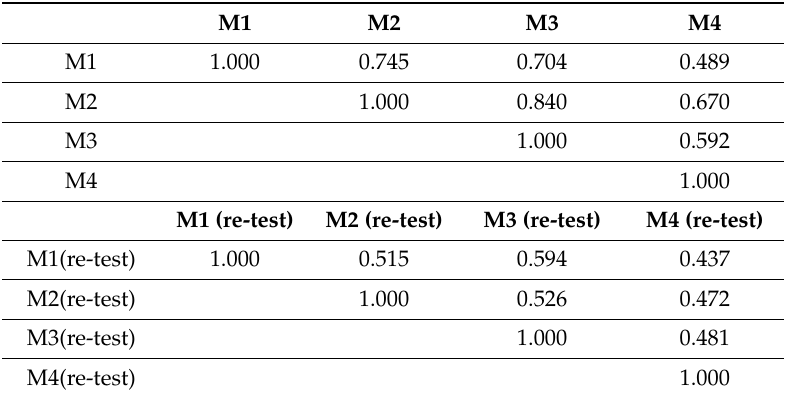
Table 4. Inter-item correlation for the two MARS